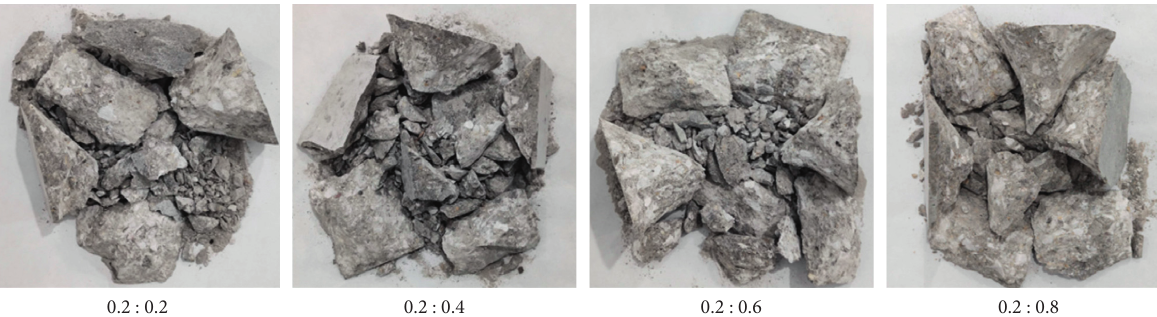
Figure 16: Fracture morphology of specimens under different stress